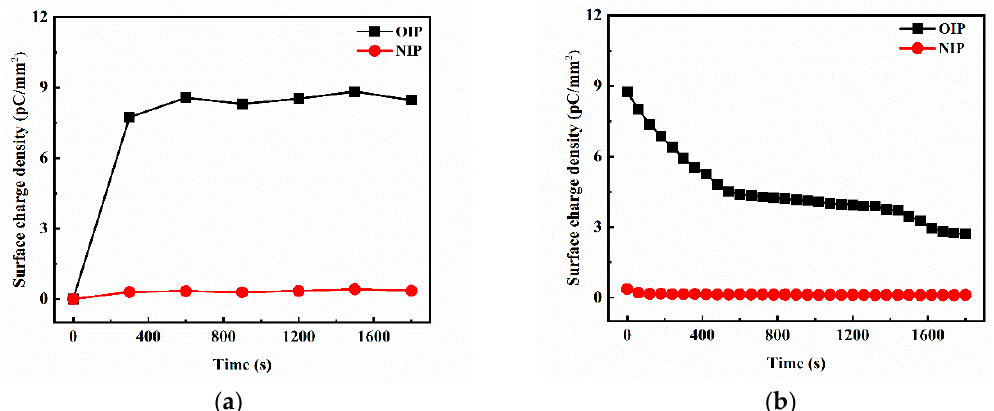
Figure 10. ( a ) Charge accumulation characteristics and ( b ) charge dissipation characteristics of OIP and NIP samples.